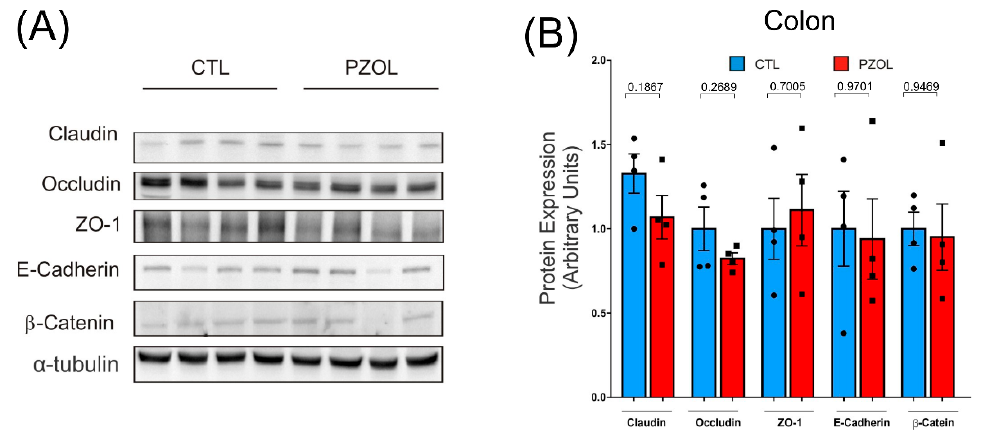
Figure 5. Pantoprazole does not induce alterations in epithelial barrier integrity in colon. ( A ) Tissue levels of tight junction proteins (claudin, occludin and ZO-1), and tissue levels of adherens junction proteins (e-cadherin and beta-catenin); ( B ) quantification of the Western blots ( n = 4 to 8 animals per group). Data are expressed as mean ± standard deviation and t -test statistical comparisons.